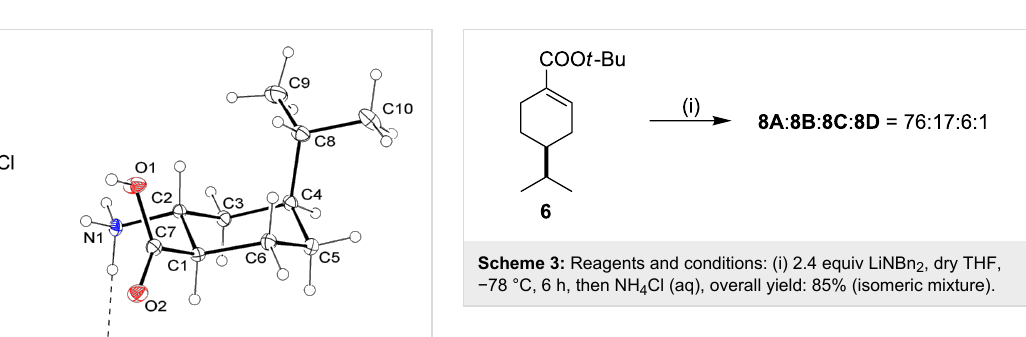
yield (Scheme 4). In addition to the NOESY examinations,